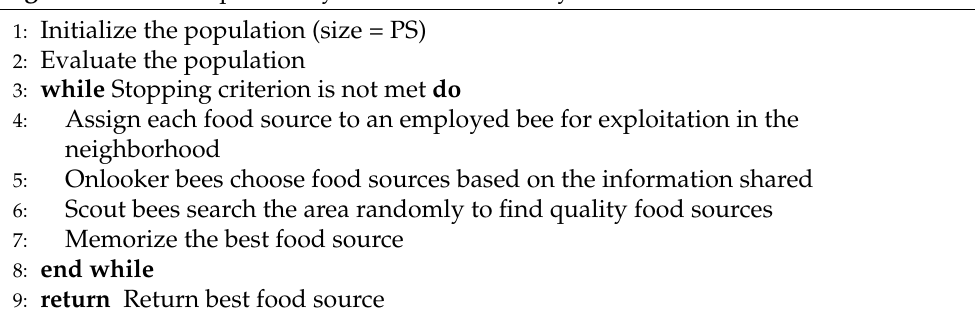
Algorithm 1 Search process by Artificial Bee